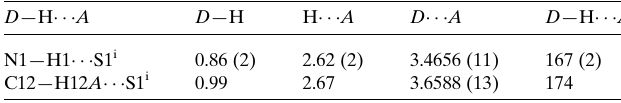
Table 3 Hydrogen-bond geometry (A˚ , (cid:2) ) for 3 . D —H (cid:4)(cid:4)(cid:4) A